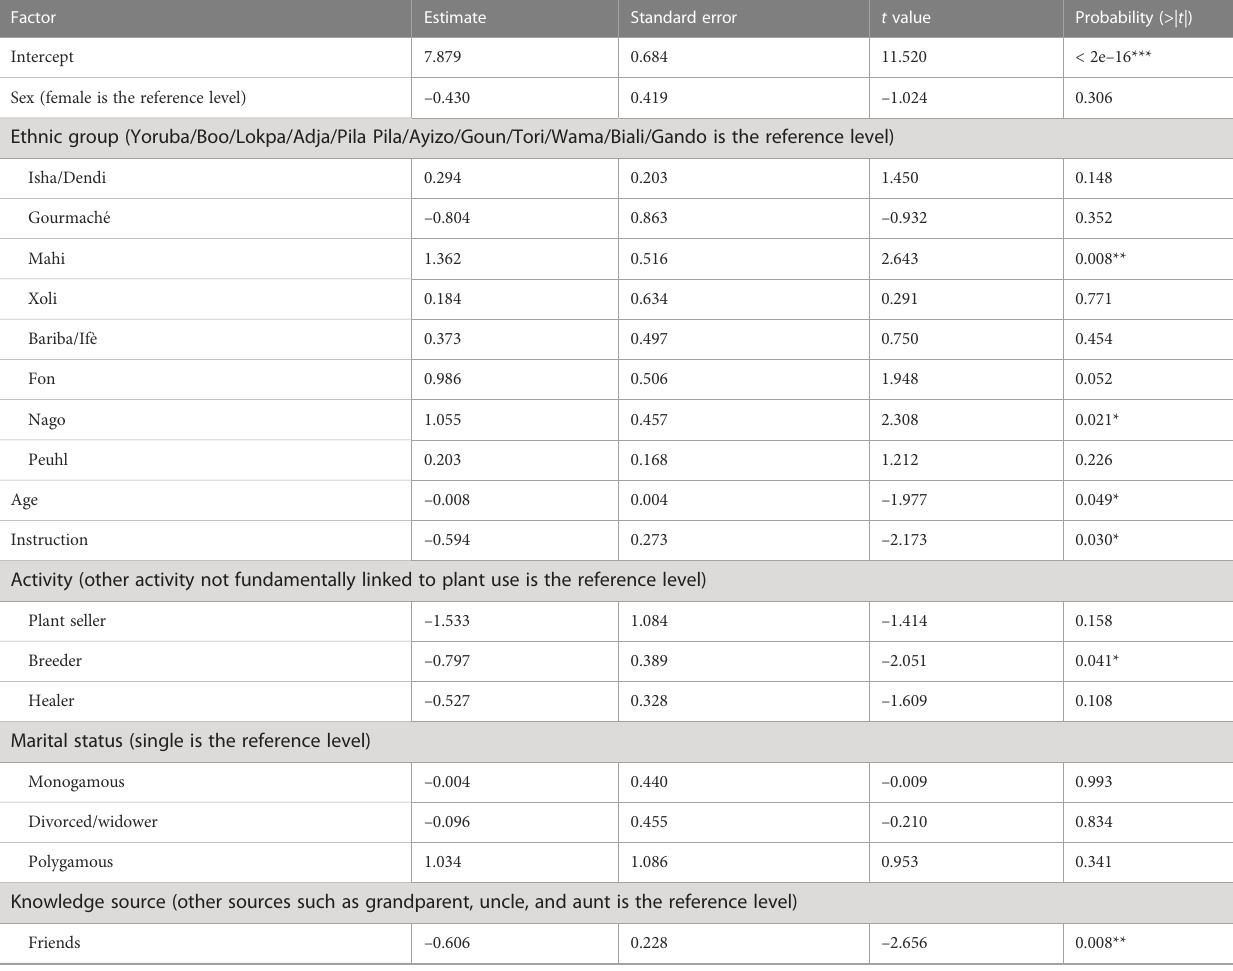
TABLE 3 Generalized linear model (GLM) output of the effects of sociodemography on ethnomedicinal knowledge.